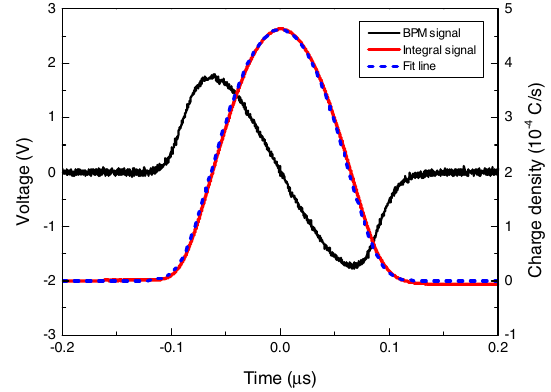
FIG. 4. The measured BPM signal (black) of the bunched beam, the beam linear charge density (red) calculated from the BPM signal and the Fokker-Plank fitting result (blue) in the experiment of 3 . 7 MeV = u 112 Sn 36 þ . The rms bunch length is ¼ 1 . 4 kV, g ¼ 3 . 7 , σ ¼ about 28 (cid:2) 0 . 2 ns ( I ¼ 17 . 7 μ A, V rf 2 . 3 × 10 − 4 ).